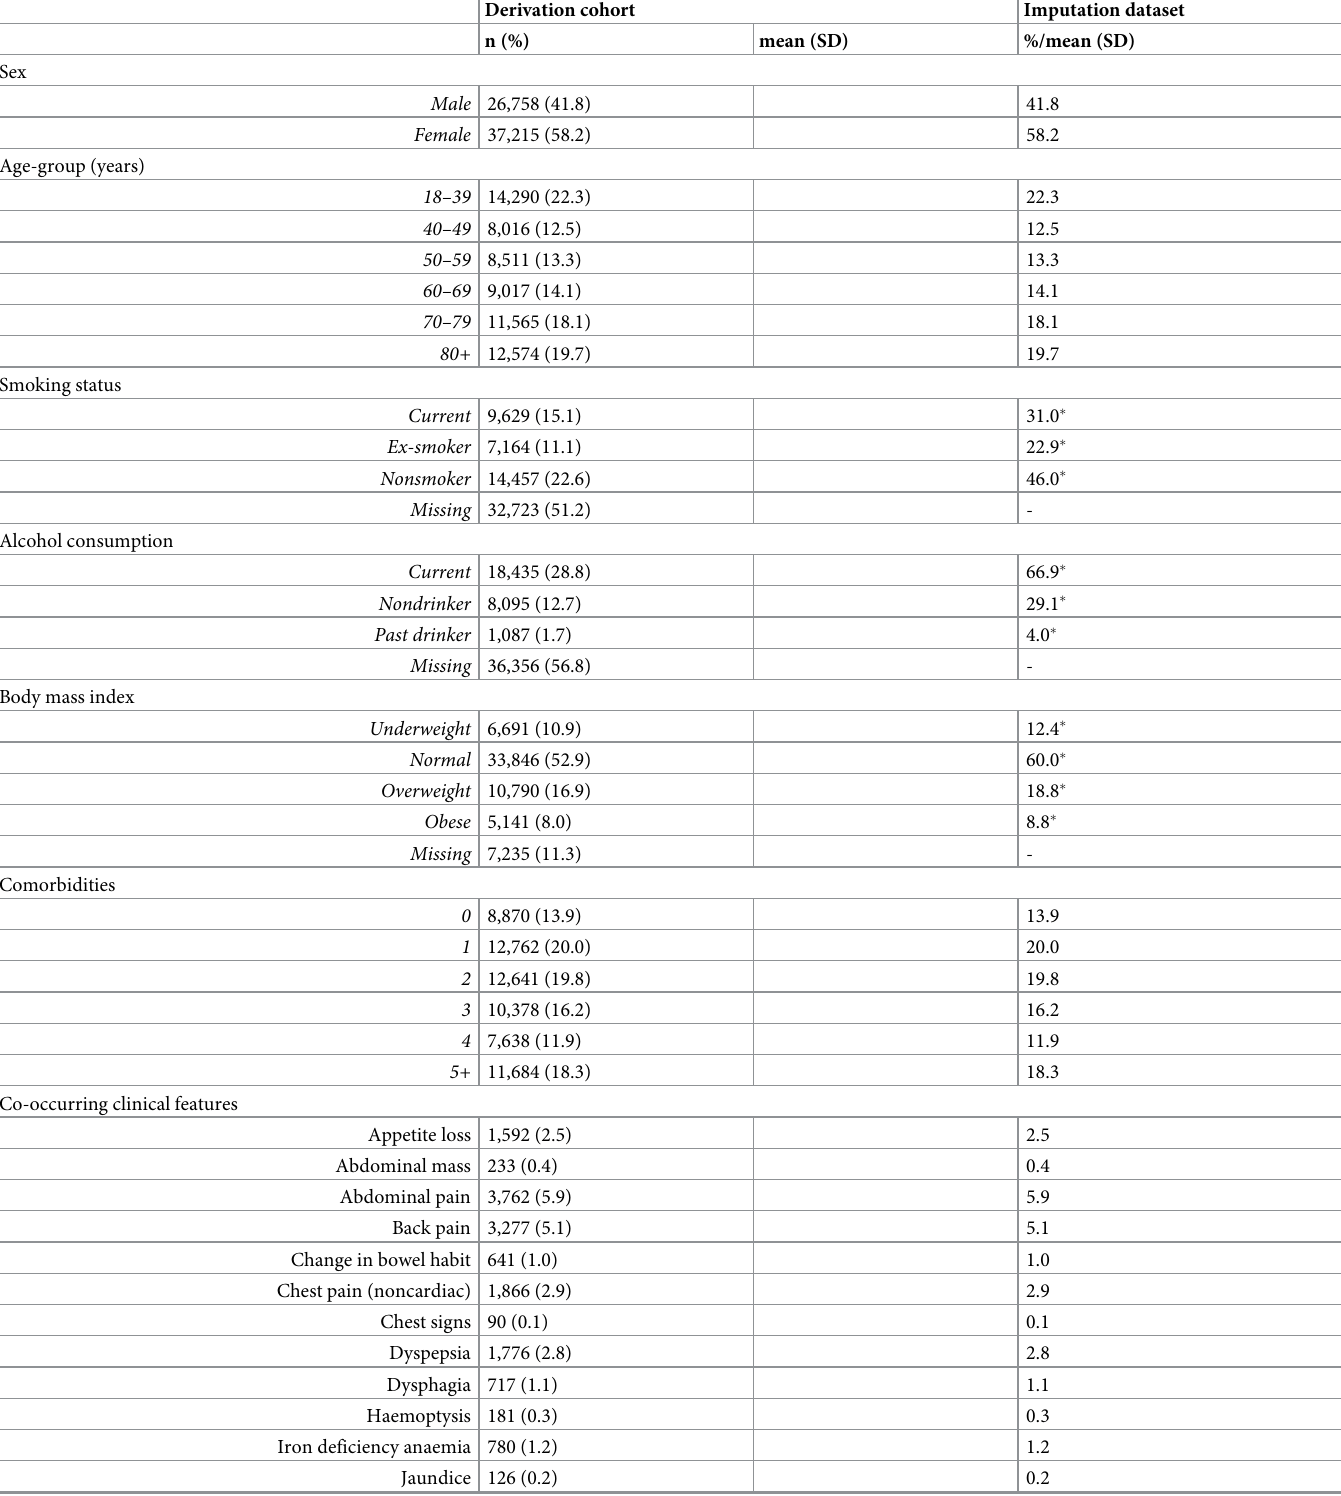
Table 1. Baseline characteristics of the derivation cohort and imputation